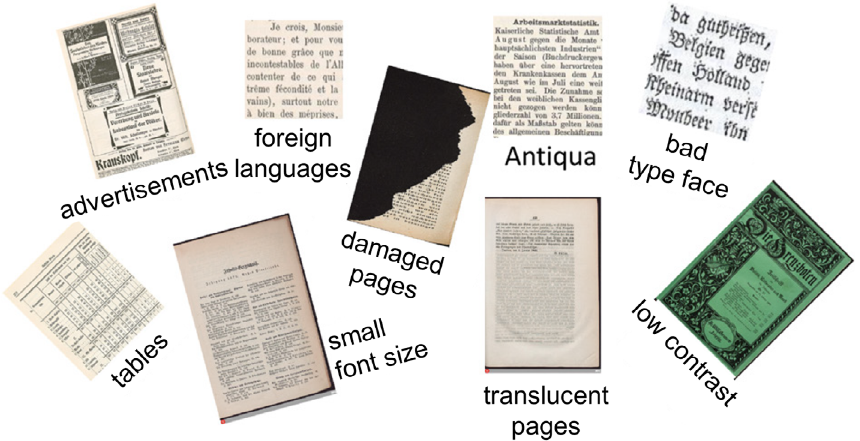
Fig. 3 Sample results of an automated quality assurance using OCR full text OCR post correction